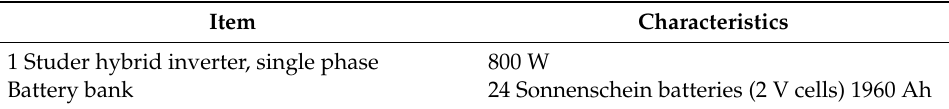
Table 6. Energetic requirement for O ff -Grid plant. Development company of the photovoltaic plant